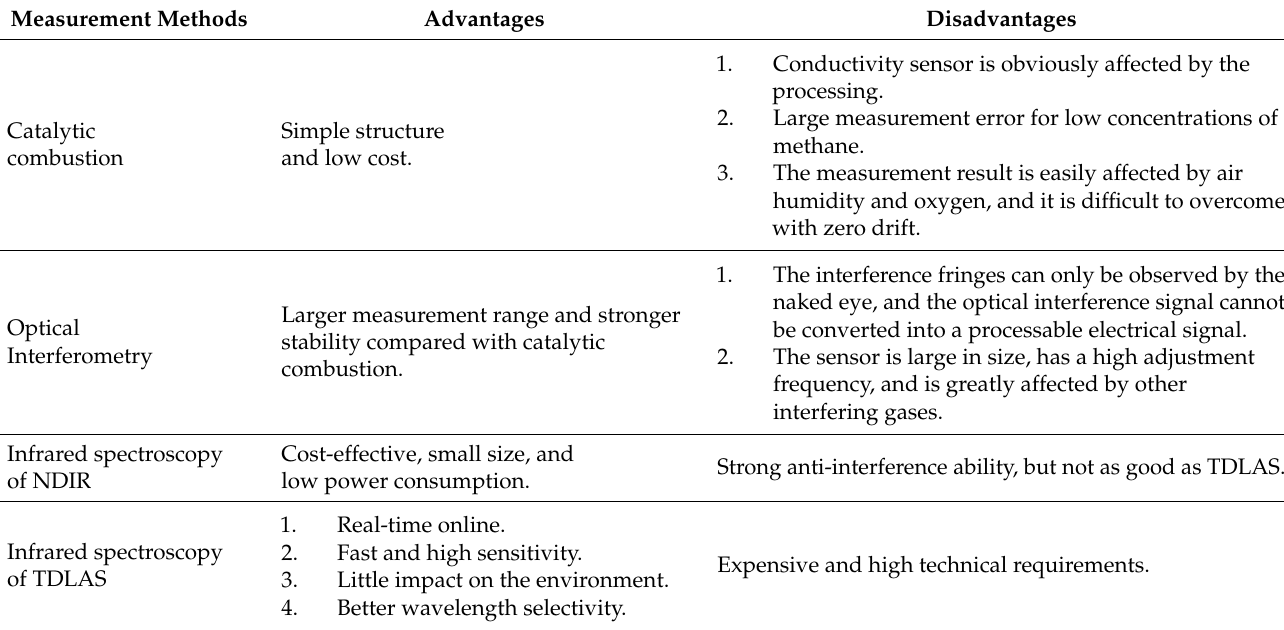
Table 1. Comparison of methane concentration measurement